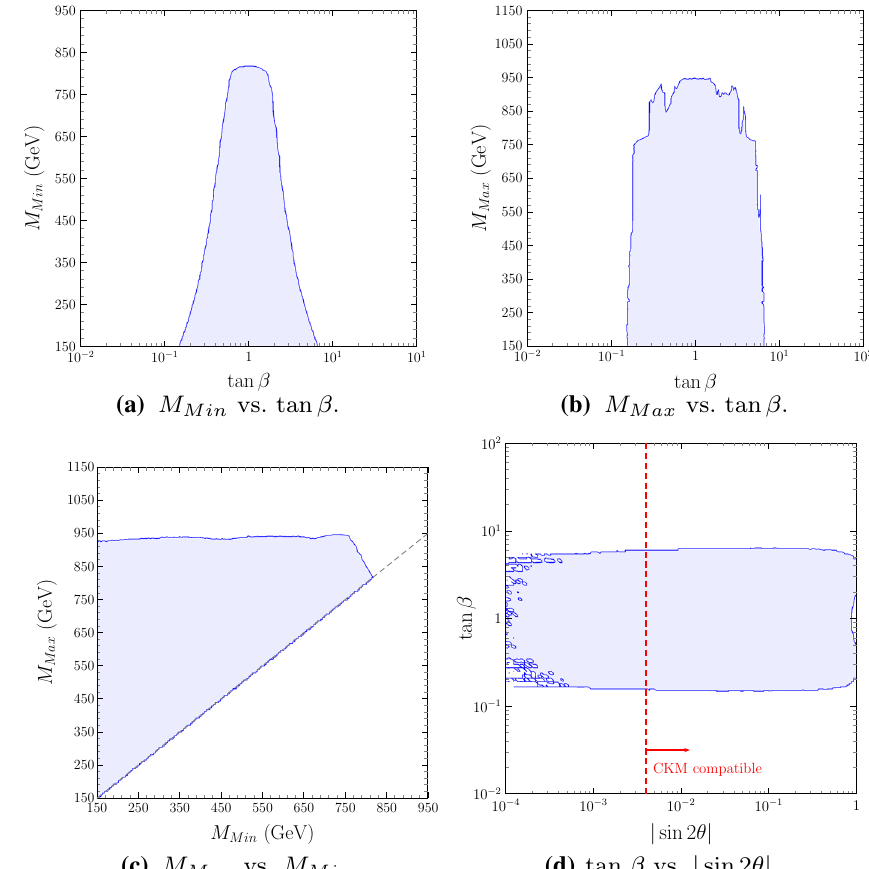
Fig. 3 Regions allowed at 99% CL by the requirements on the scalar sector